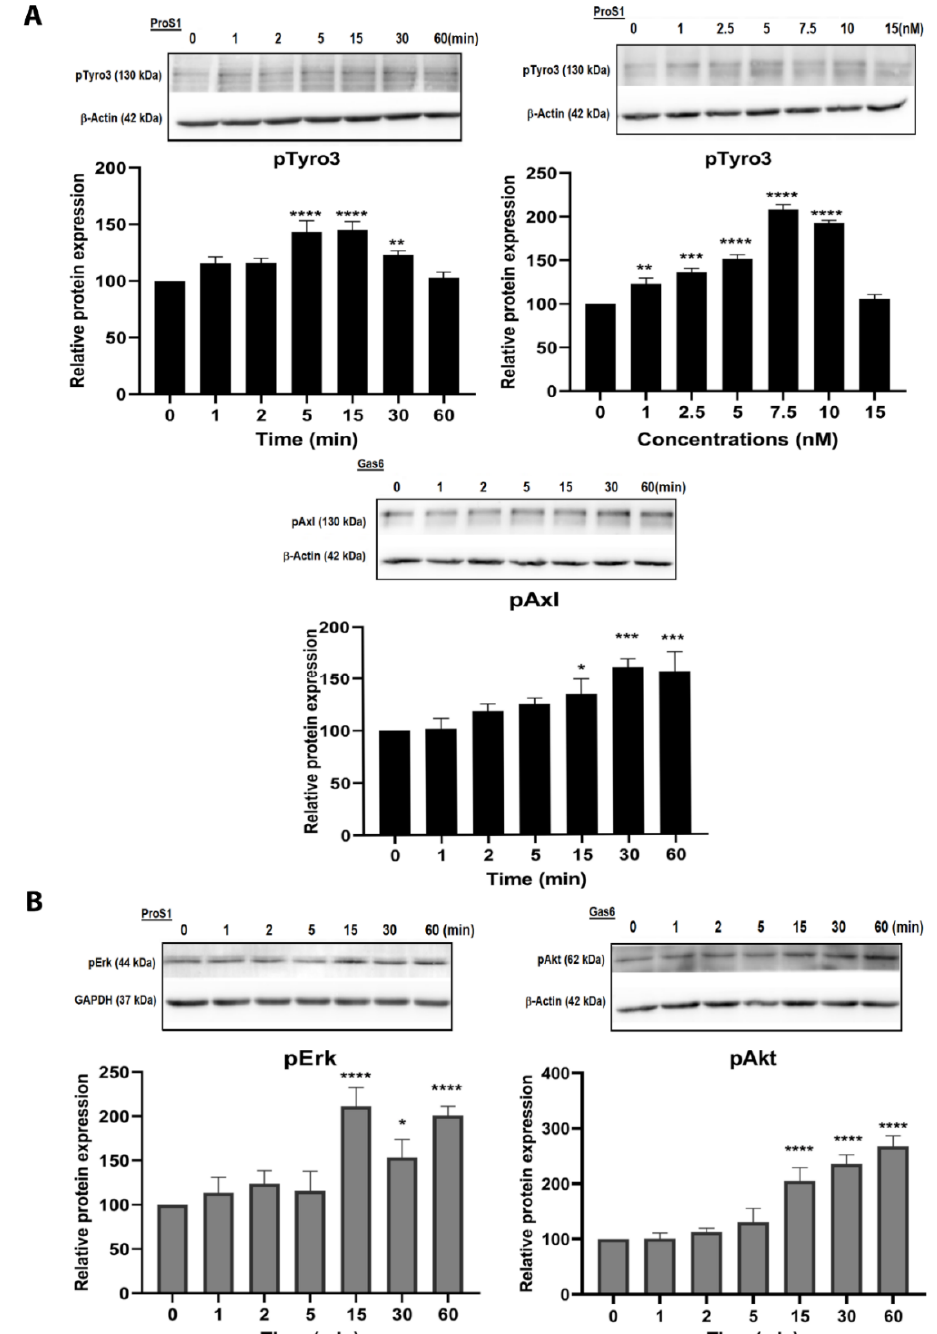
Figure 2. Effect of ProS1 and Gas6 stimulation on phosphorylation of TAM receptors and intracellular signalling kinases in SCC-25 cells. ( A ) Representative Western blots showing phosphorylated Tyro3 (pTyro3) protein in SCC-25 cells stimulated by ProS1 (7.5 nM) in time-course and dose response experiments, and phosphorylated Axl (pAxl) protein in cells stimulated over a time-course by Gas6 (5.7 nM). ( B ) Representative Western blot images show time-course of Erk phosphorylation (pErk) and Akt phosphorylation (pAkt). Accompanying graphs show protein quantification by densitometric analysis of bands. Data are mean ± SEM protein expression normalized against GAPDH or β -actin as loading control protein; ANOVA with Tukey’s multiple comparison post-hoc analysis; **** p < 0.0001, *** p < 0.001, ** p < 0.01, * p < 0.05, versus control (time 0 or untreated) (n = three separate experiments).